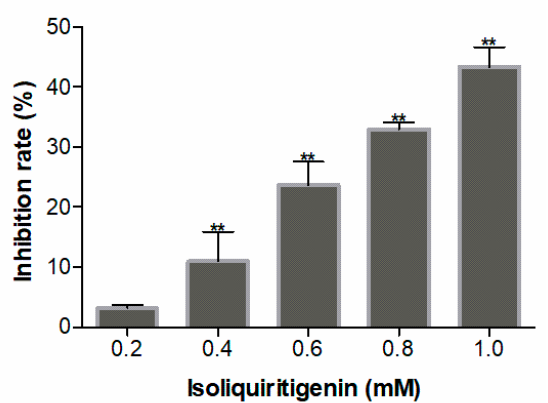
Figure 1. Allelopathic effect of isoliquiritigenin on radicle growth of lettuce seedlings. Values are expressed as a percentage of the mean compared to the control. Error bars are one standard deviation of the mean. N = 3. One asterisk * and two asterisks ** represent the significant difference between isoliquiritigenin-treated lettuce seedlings and the control at p < 0.05 and p < 0.01, respectively.